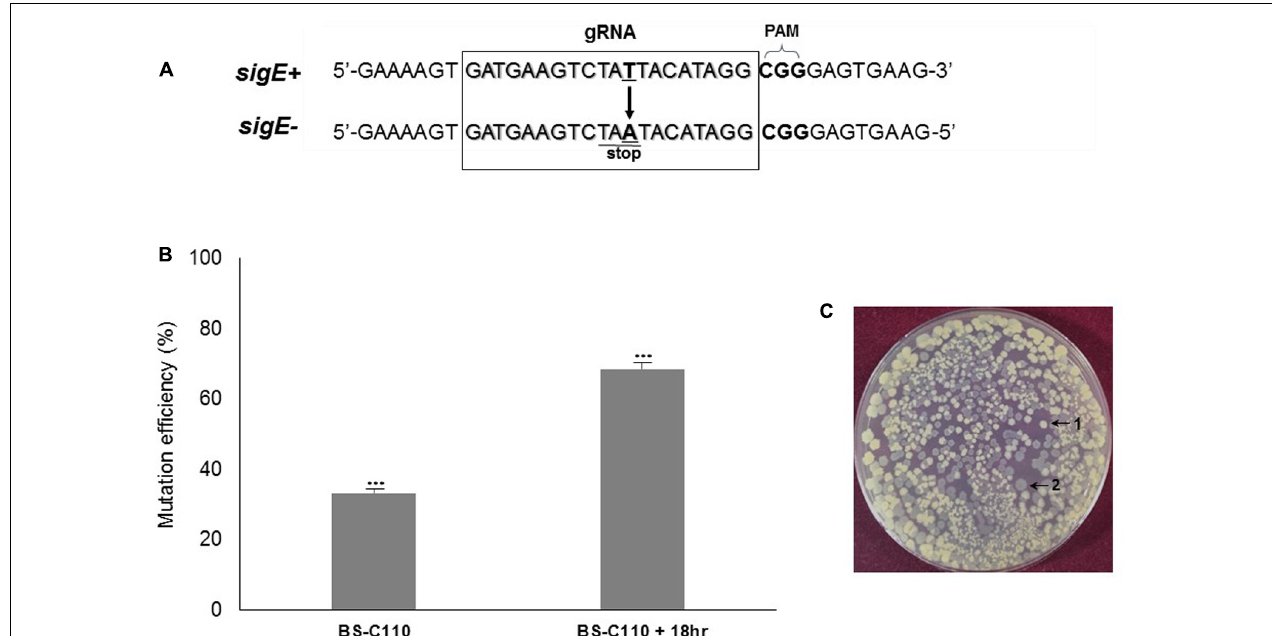
FIGURE 5 | sigE point mutation efficiency. (A) The squared region represents the 20 bp sigE -targeting gRNA sequence. The thymine (T) was changed into adenine (A) to produce a stop codon. (B) Prolonged incubation (18 h) in selective media increased mutation efficiency from 33 to 68%. The means of three independent technical replica experiments are presented; error bars represent standard deviations. ∗∗∗ P < 0.001 compared with control without presence of pHCas9. (C) Two different B. subtilis phenotypes; 1 indicates wild type B. subtilis 168 whereas 2 indicates transparent sigE mutant BS-C110.